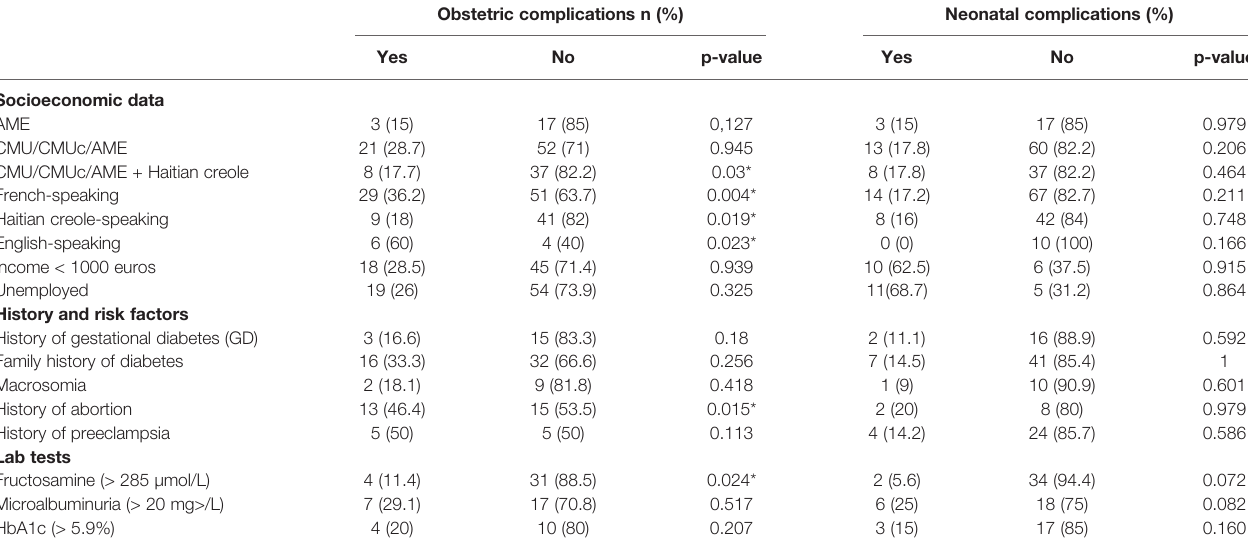
TABLE 3 | Bivariate analysis of socioeconomic and medical data in relation to onset of obstetric or neonatal complications. Obstetric complications n